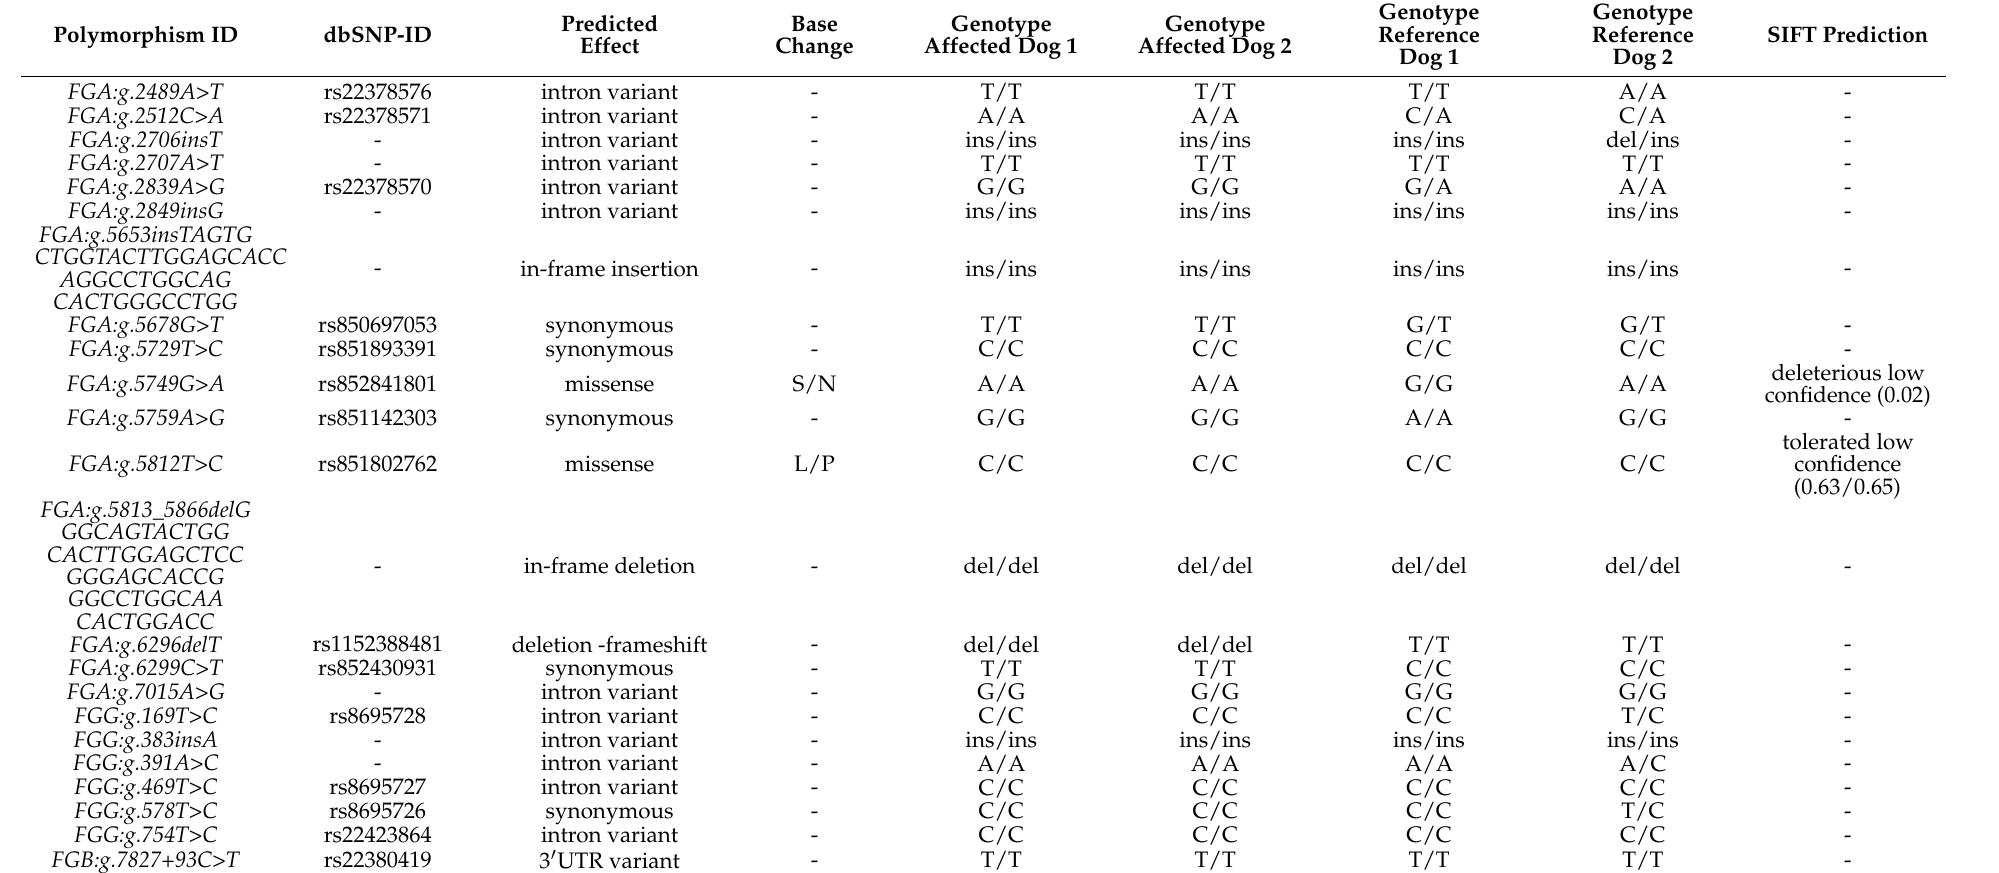
Table 1. Variants detected in sequencing analysis of the candidate genes FGA , FGB , and FGG . The predicted effect on gene sequence, genotypes of afibrinogenemic dogs and two controls, and SIFT predictions are